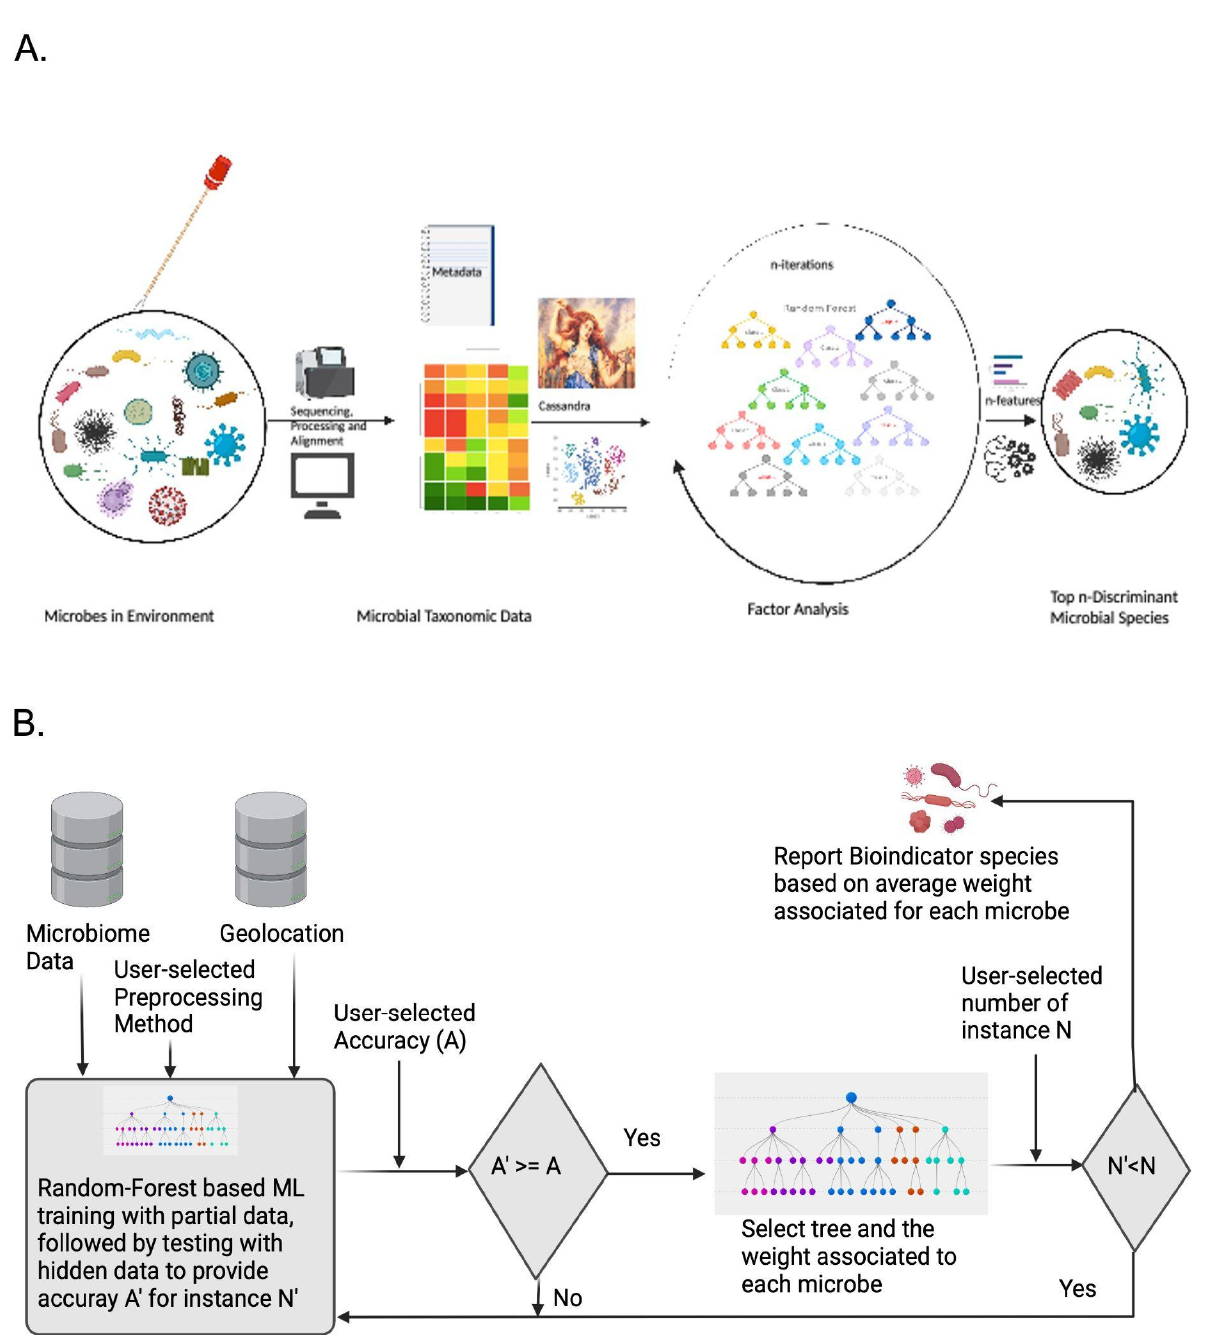
dataset to predict bioindicator species with >80% accuracy for cities and >90% accuracy for continents and >85% accuracy for predicting OTUs for the Tara Oceans dataset.